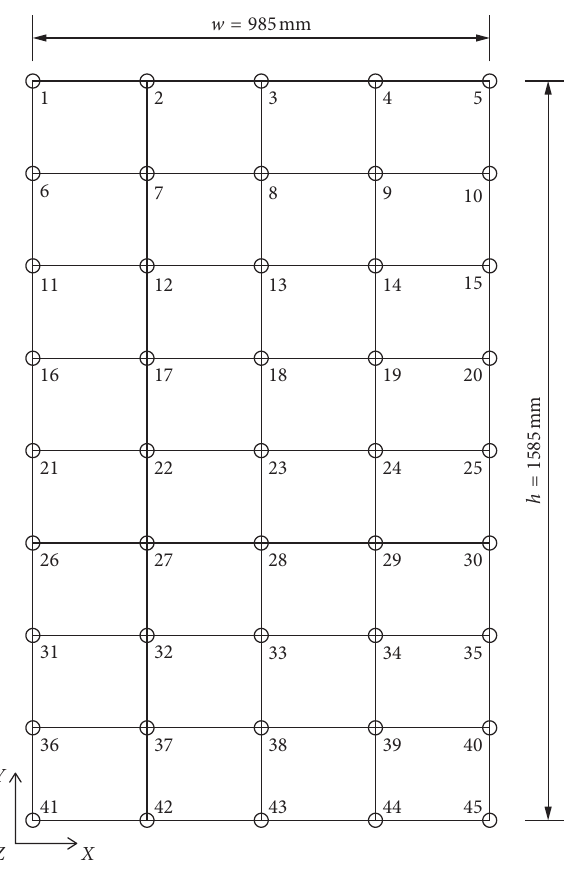
Figure 13: Driving points in experimental modal analysis (unit: